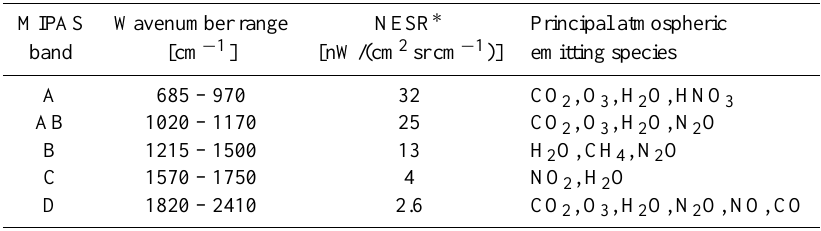
Table 1. MIPAS spectral bands.